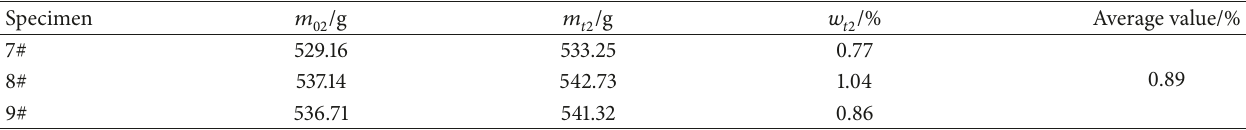
Table 2: Weight of specimens in boiled saturated and dry state and their water content.